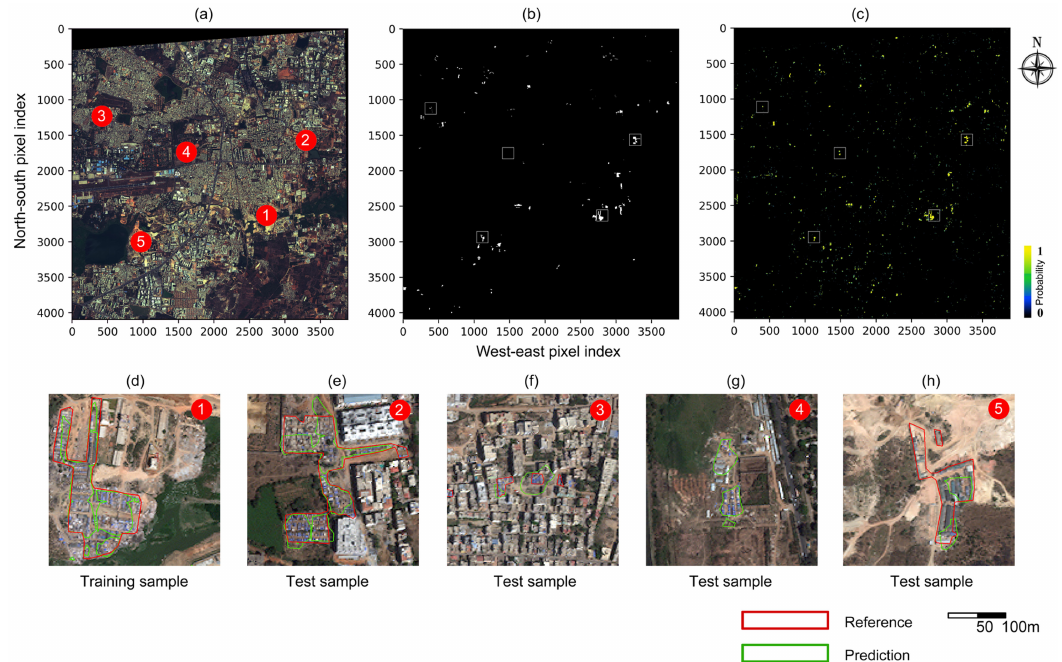
Figure 5. Citywide-level mapping of deprived areas in Bangalore, India: ( a ) 8 km × 8 km coverage of downtown Bangalore with numbered sample areas for illustration; ( b ) reference data with sample areas highlighted by boxes; ( c ) predicted deprived areas with sample areas highlighted by boxes; ( d ) zoomed-in sample area containing the training samples; and ( e – h ) zoomed-in sample areas of predictions with reference data superimposed (Image source: WorldView-2 images provided by